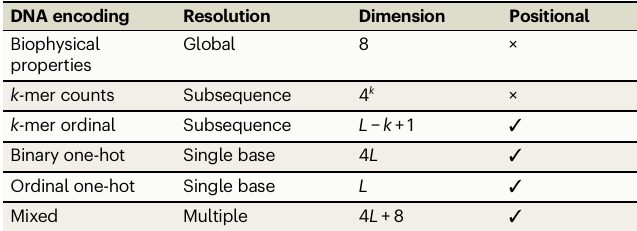
Table 1 | DNA encodings for model training DNA